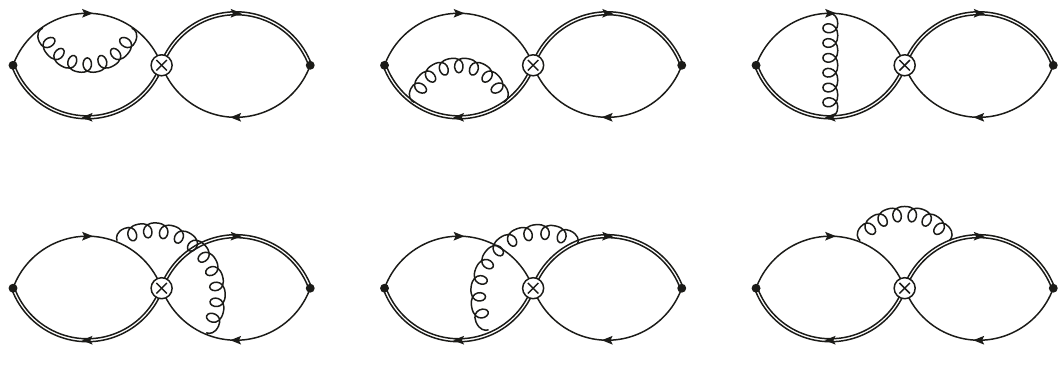
Figure 3 . Diagrams contributing to the three-point HQET correlator (3.1) at NLO. Symmetric diagrams are not